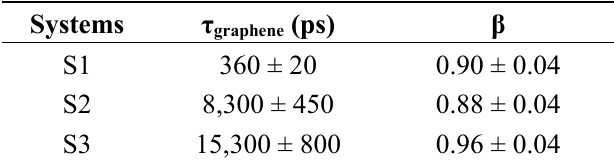
Figure 13. The time autocorrelation function of bond order parameter P 1 ( t ) as a function of time for a characteristic vector along the half diagonal of the graphene sheet for S1, S2 and S3 systems. Table 4. Orientational relaxation times τ graphene defined for a characteristic vector along the half diagonal of the graphene sheet and stretch exponents β for S1, S2 and S3 systems. Error bars are obtained from the standard deviations, based on block averaging calculations throughout the simulation